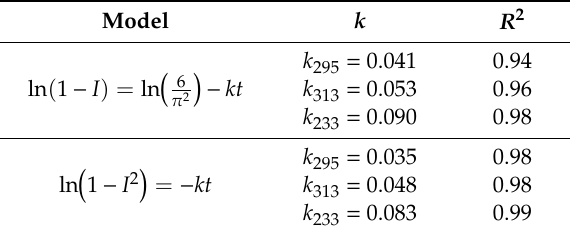
Figure 15. The dependences of the iron (III) and yttrium extraction degree from industrial phosphoric acid solution on the phase contact time.